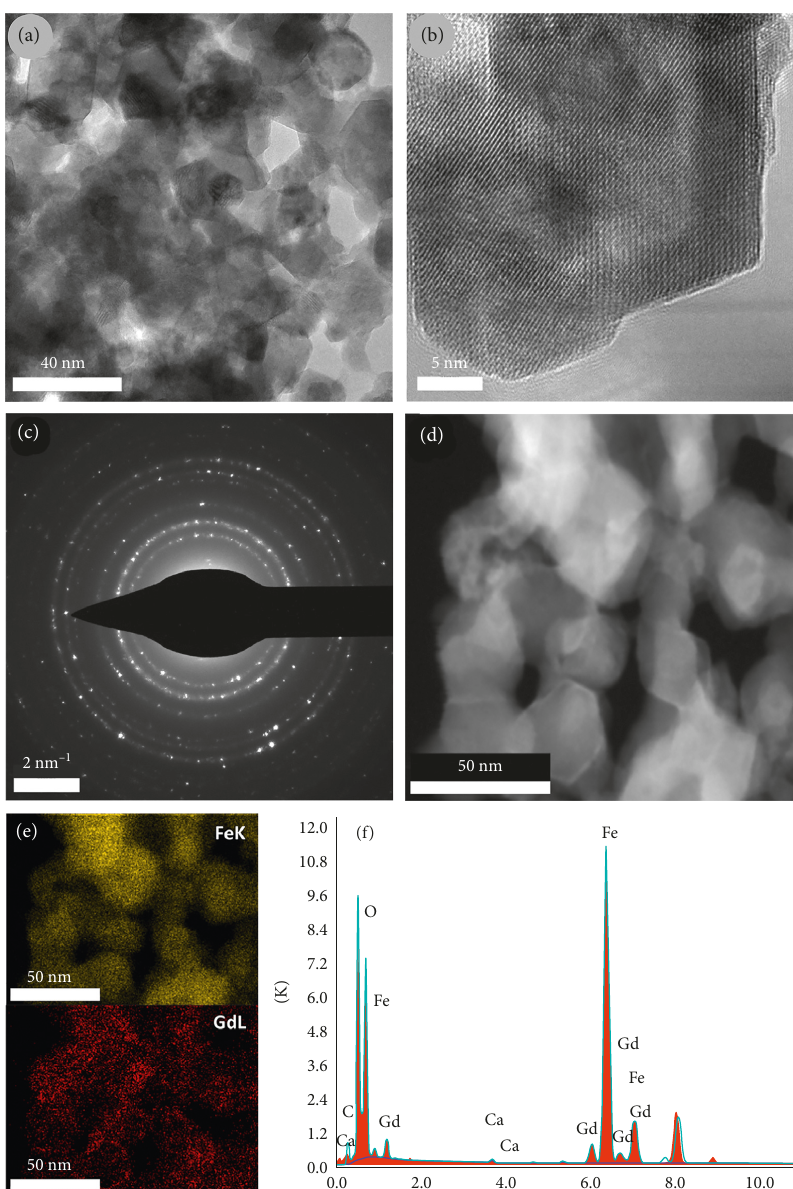
Figure 3: Electronic imaging of the MNP-Gd5.1% sample: (a, b) HR-TEM images; (c) SAED image; (d) STEM image; (e) EDS mapping at the Fe K edge (above) and Gd L edge (below) on the selected area in image (d); (f) EDS histogram of elemental composition in a typical point of the